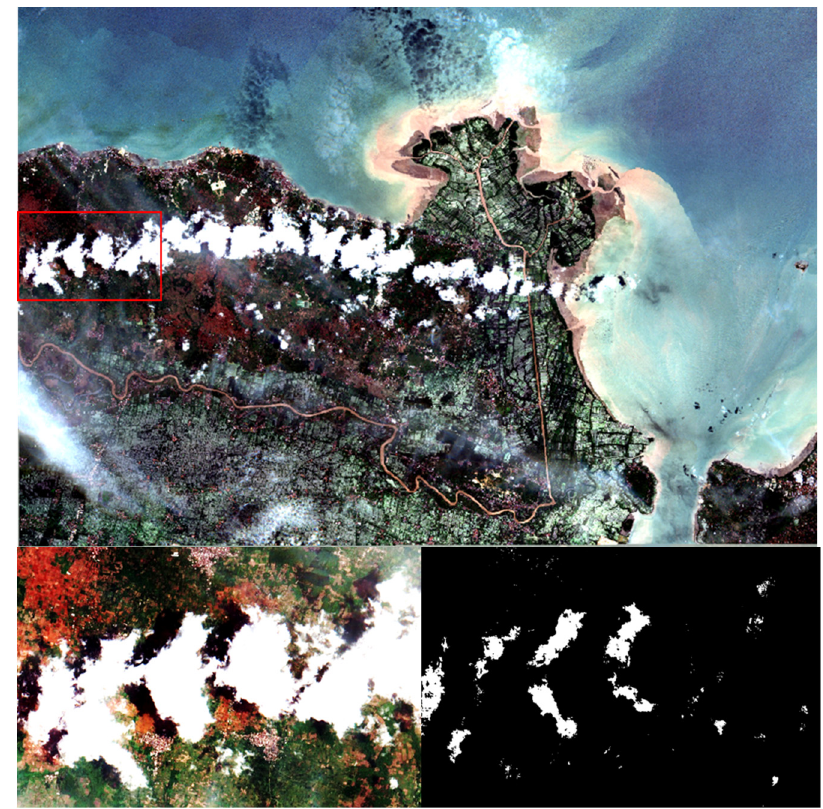
Figure 1. Full Sentinel-2 tile processed for the Solo River, Indonesia, as the pseudo-true colour image (bands B04, B03 and B02 as red, green, and blue) at the top, with a zoomed-in (see red box) comparison of pseudo-true colour to the pixels that have been identified using the shadow index for a subset.